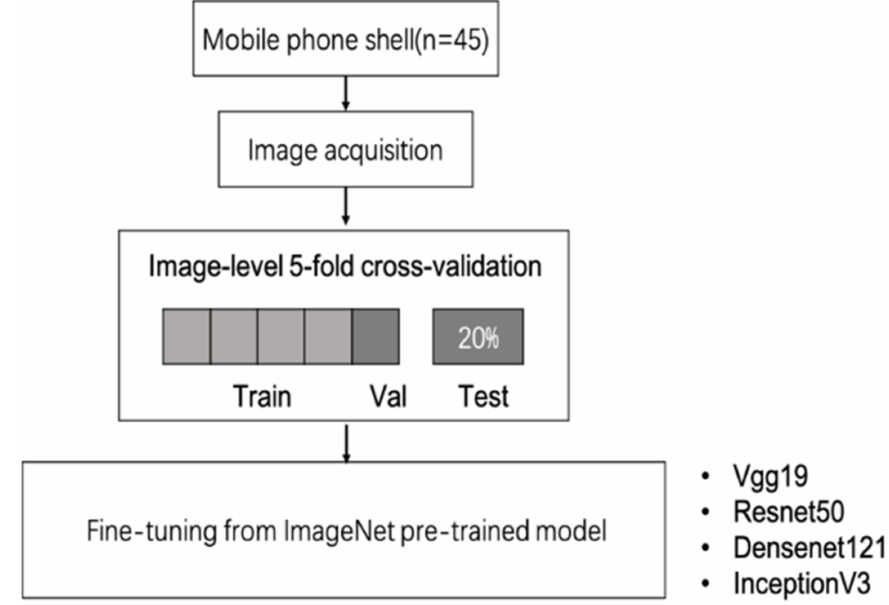
Figure 1. Design of